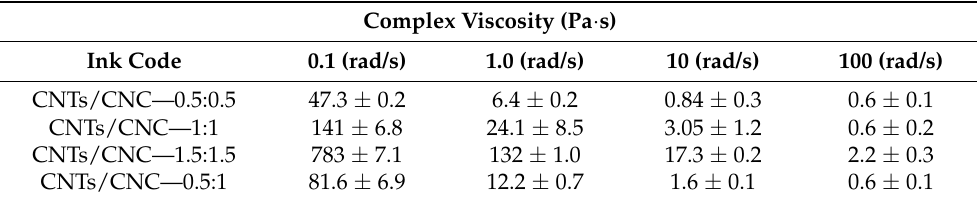
Table 5. Complex viscosity values at different angular frequencies.